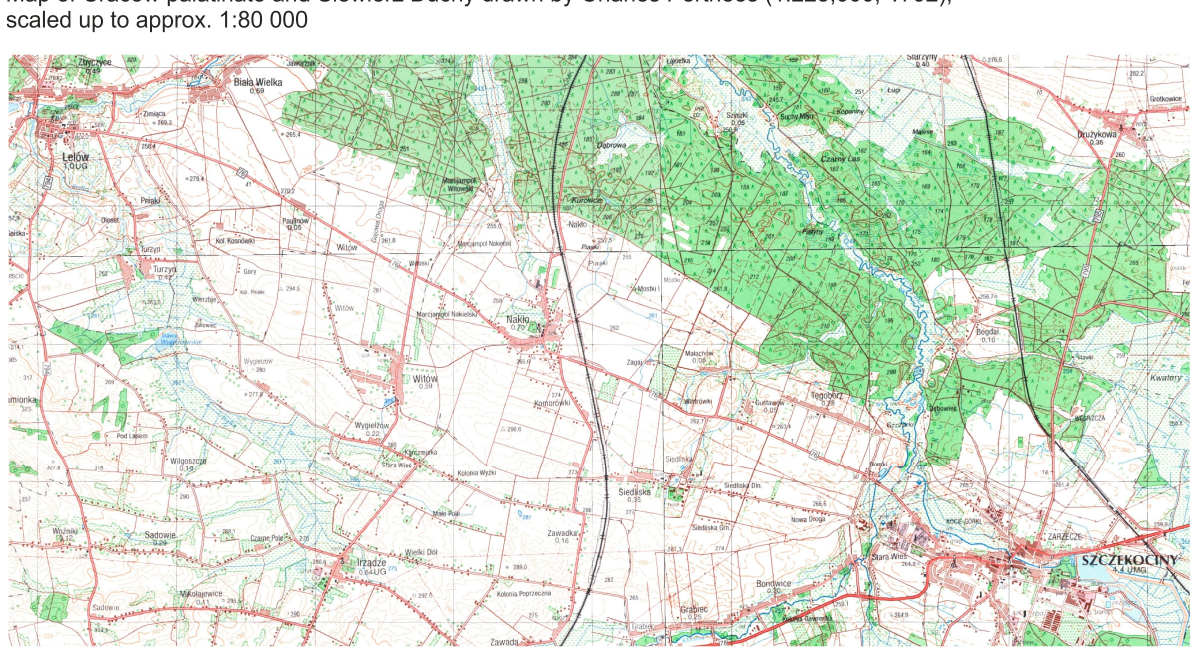
Figure 1. A perfect example of inaccurate maps is the ‘special maps of palatinates of Poland’ drawn by Charles Perthées (upper) juxtaposed with a modern map of the same area (lower). Topographic features on inaccurate maps roughly correspond with their modern counterparts. Such maps cannot be georeferenced due to large mathematical errors which would cause enormous distortions. Therefore, a special approach towards them has to be adapted in the context of data